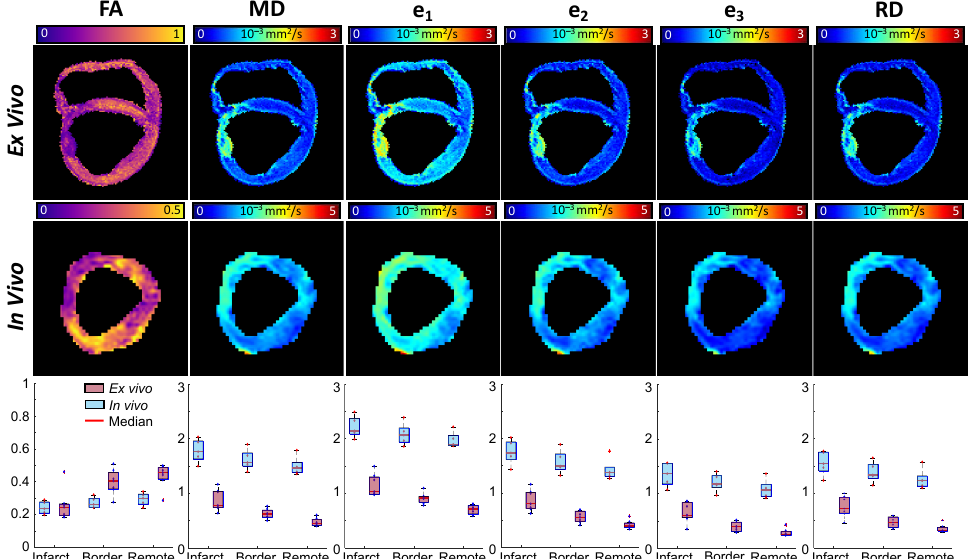
Figure 7. FA, MD, e 1 , e 2 , e 3 , and RD mappings for a representative slice from data acquired ex vivo (top) and in vivo (mid). Ex vivo and in vivo diffusion quantities across all subjects are compared using boxplots (bottom). These boxplots are constructed based on the subject-wise medians of the diffusion